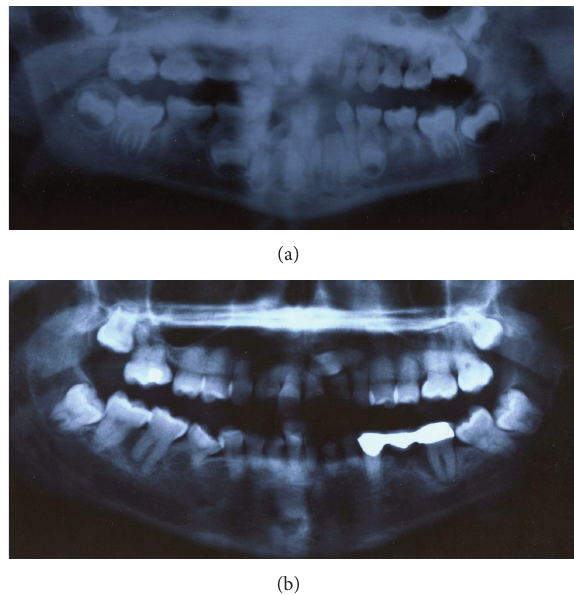
Figure 1: Dental X-rays performed at the age of 6 (a) and the age of 19 (b). The lower second bicuspids are absent. There are two supernumerary teeth underneath her secondary lower incisors, which may represent ectopic, malformed